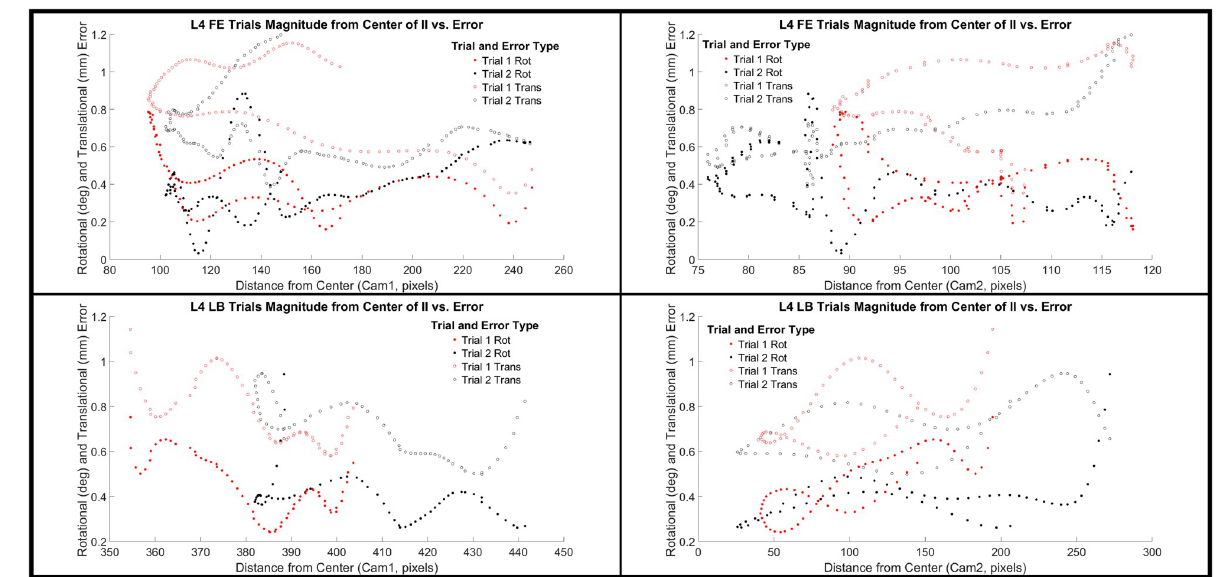
Fig 5. L4 distance from center of image intensifiers compared to tracking error. Overall rotational (degrees) and translational (mm) error magnitude is plotted against the distance of spinal level L4 relative to the center of the image intensifier (II) for each trial of flexion extension (FE) and lateral bending (LB) and each camera (1 and